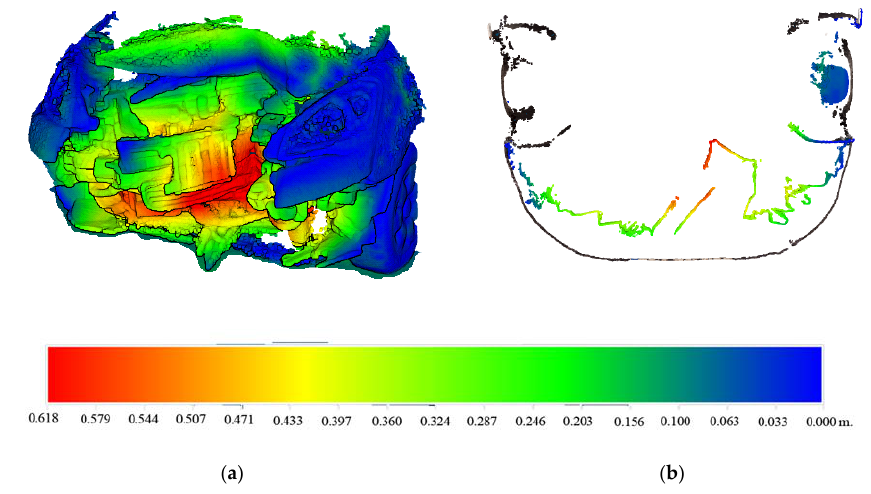
Figure 9. Comparison between 3D photogrammetric models: ( a ) isometric view of the damaged model, and ( b ) plan view of the section considered for the energetic analysis. The points belonging to the undamaged model are in black.